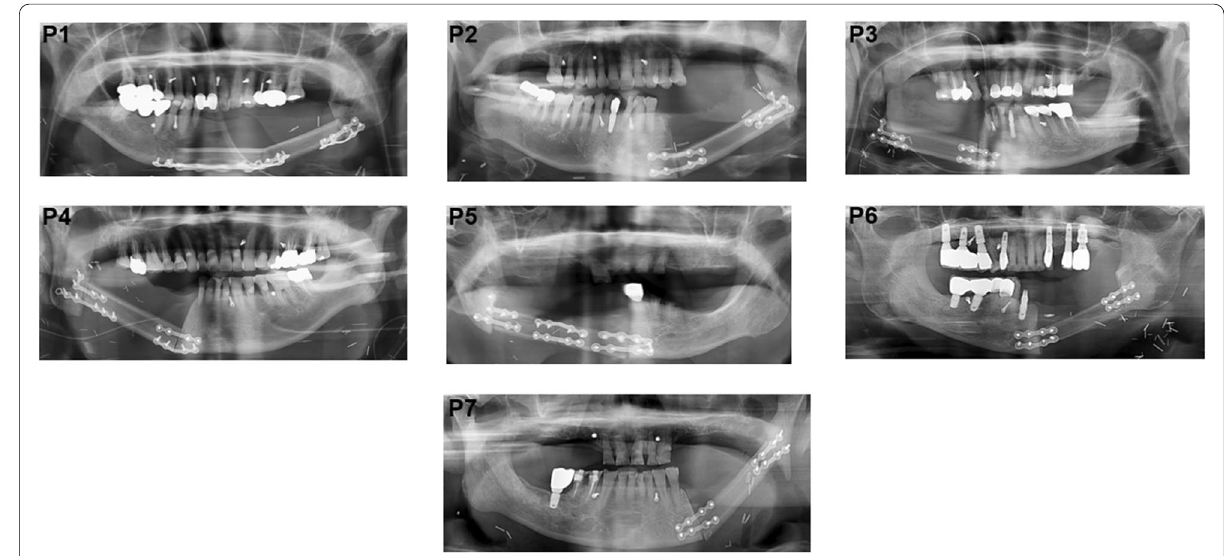
Fig. 2 Postoperative orthopantomogram X‑rays of the patients